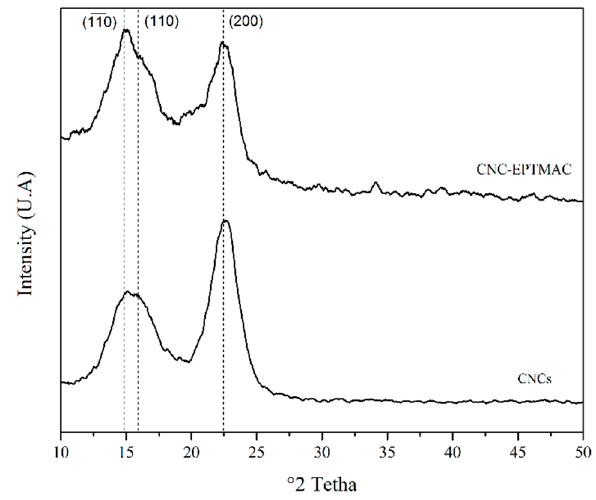
Figure 4. Crystallinity properties, XRD analysis.